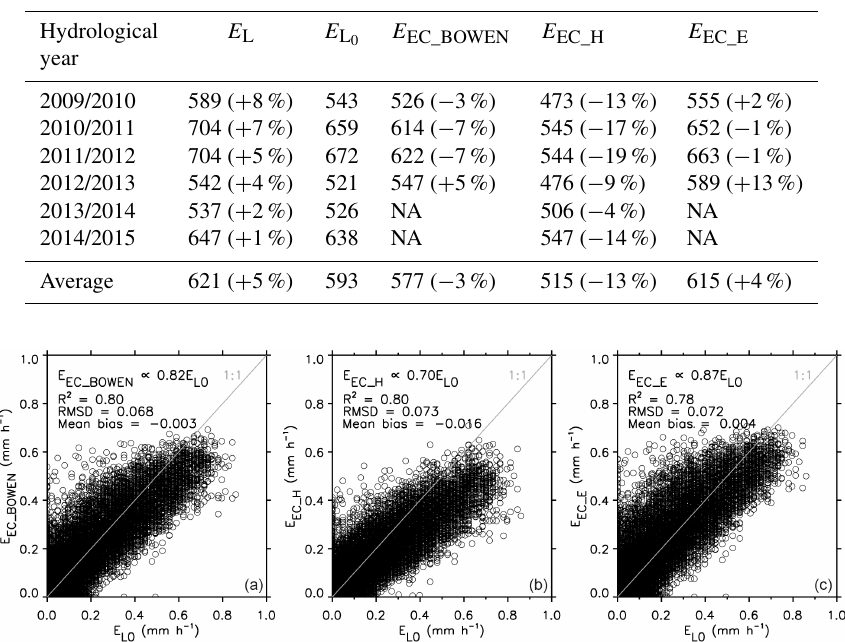
Figure 7. Comparison of hourly EC-based evapotranspiration E EC with lysimeter evapotranspiration E L excluding gap-filled data, and masked for precipitation and wind directions affected by the tower) in the time period 1 June 2009–31 De- cember 2015 ( n = 30615 for E EC_H respectively n = 30002 for E EC_BOWEN and E EC_E ). The comparison is shown separately for E EC corrected according to (a) the Bowen ratio ( E EC_BOWEN ), and E EC corrected by assigning the energy balance closure gap to (b) sensible heat-flux only ( E EC_H ) and to (c) latent heat-flux only ( E EC_E )